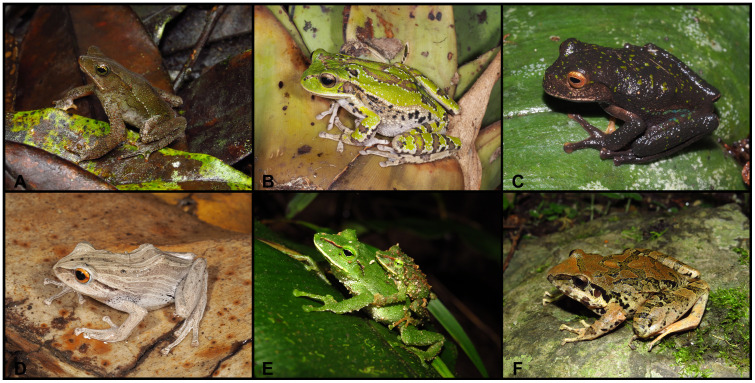
Other amphibian species present in Abra de Zamora.A. Rhinella margaritifera, from Parque Nacional Podocarpus (Bombuscaro entrance); B. Gastrotheca elicioi, from Loja city; C. Gastrotheca testudínea, from Abra de Zamora; D. Pristimantis atratus, from Abra de Zamora; E. Pristimantis galdi, from Reserva Tapichalaca; F. Pristimantis lymani, from Loja city.